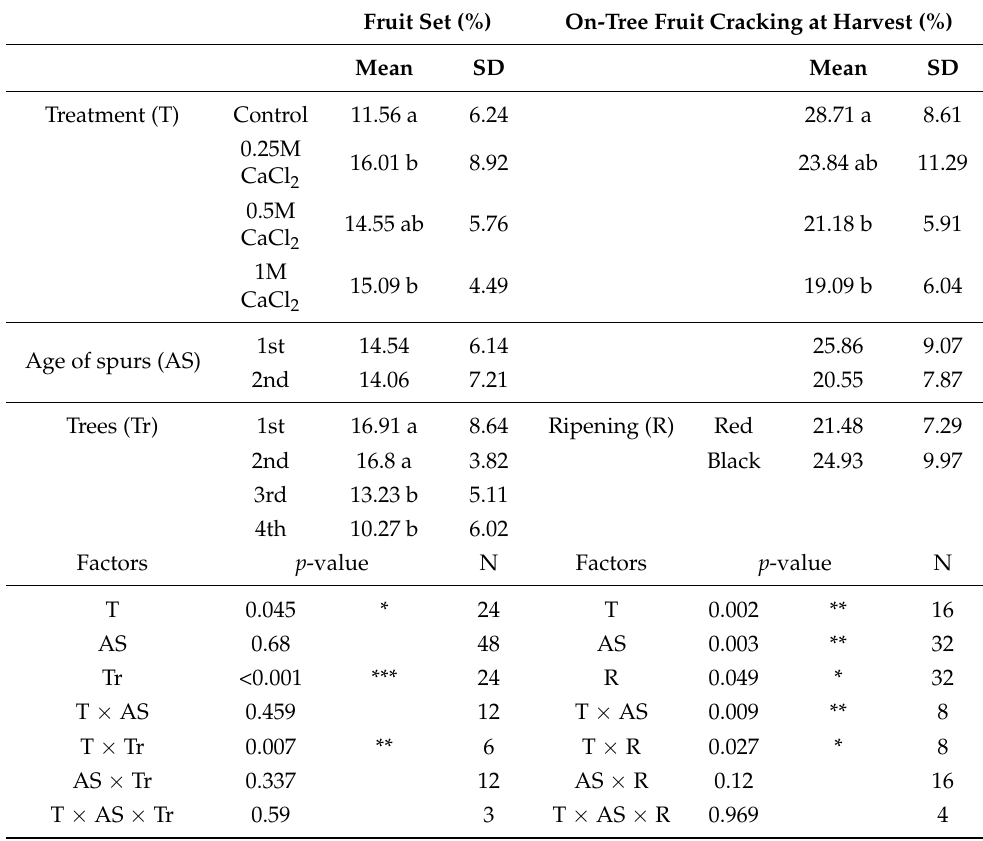
Table 1. The effect of different factors in fruit set (40 DAFB) and in on-tree fruit cracking at harvest (81 DAFB). Fruit Set